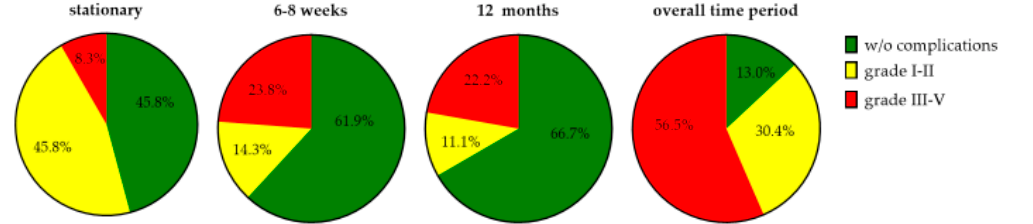
Figure 5. Postoperative complications of SG at different time points according to the Clavien-Dindo classification [20,21].